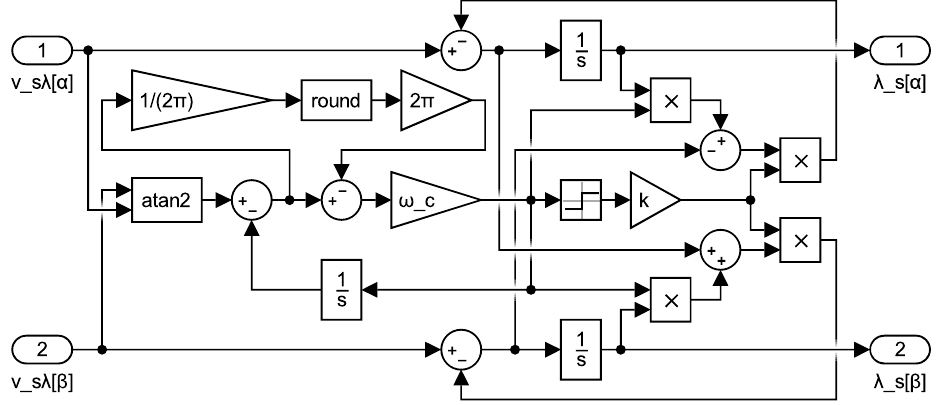
Figure 5. The Simulink diagram of the proposed compensation used for simulations.